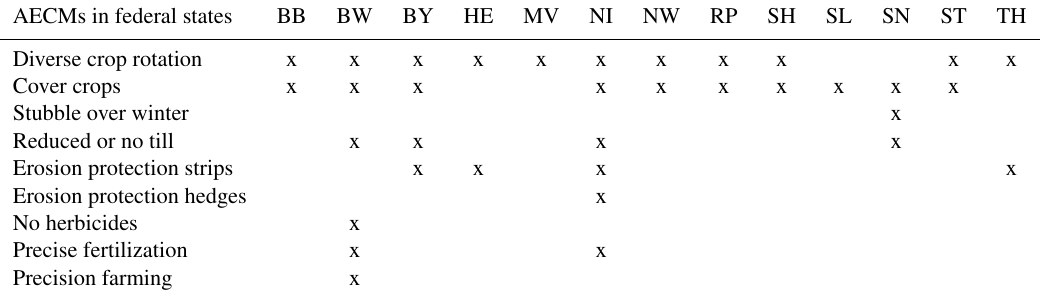
Table 2. Soil-related AECMs in German federal states. Notes: BB – Brandenburg/Berlin, BW – Baden-Württemberg, BY – Bavaria, HE – Hesse, MV – Mecklenburg-Vorpommern, NI – Lower Saxony/Bremen, NW – North Rhine-Westphalia, RP – Rhineland-Palatinate, SH – Schleswig-Holstein/Hamburg, SL – Saarland, SN – Saxony, ST – Saxony-Anhalt, TH – Thuringia. AECMs in federal states BB BW BY HE MV NI NW RP SH TH Diverse crop rotation x x x x x Cover crops x x x Stubble over winter x Reduced or no till x x x x Erosion protection strips x x x x Erosion protection hedges x No herbicides x Precise fertilization x x Precision farming